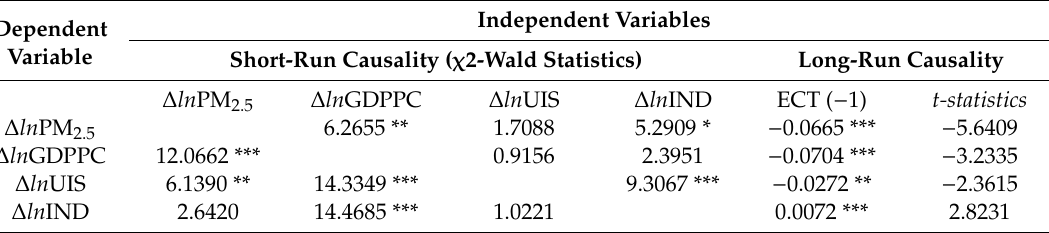
Table 5. Panel Granger causality test results.